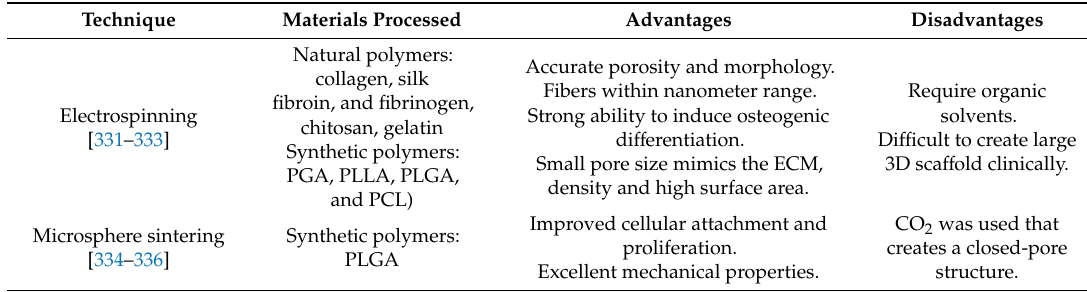
Table 6. Summary of the materials processed, advantages and disadvantages of woven or non-woven fibers technique for biomimetic sca ff old production.